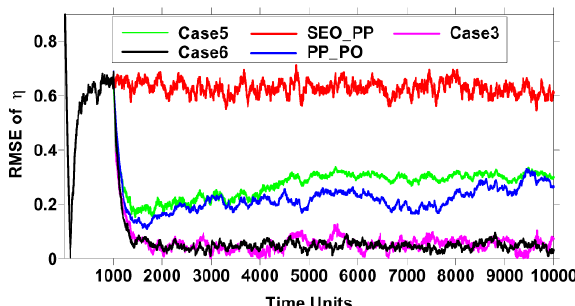
Fig. 8. Time series of RMSEs of η in 10 4 TUs in Case5 (green line) and Case6 (black line). The setups of the two experiments are de- scribed in Table 1. Note that the time series of RMSEs of η in SEO_PP (red line), PP_PO (blue line), and Case3 (pink line) are also plotted as